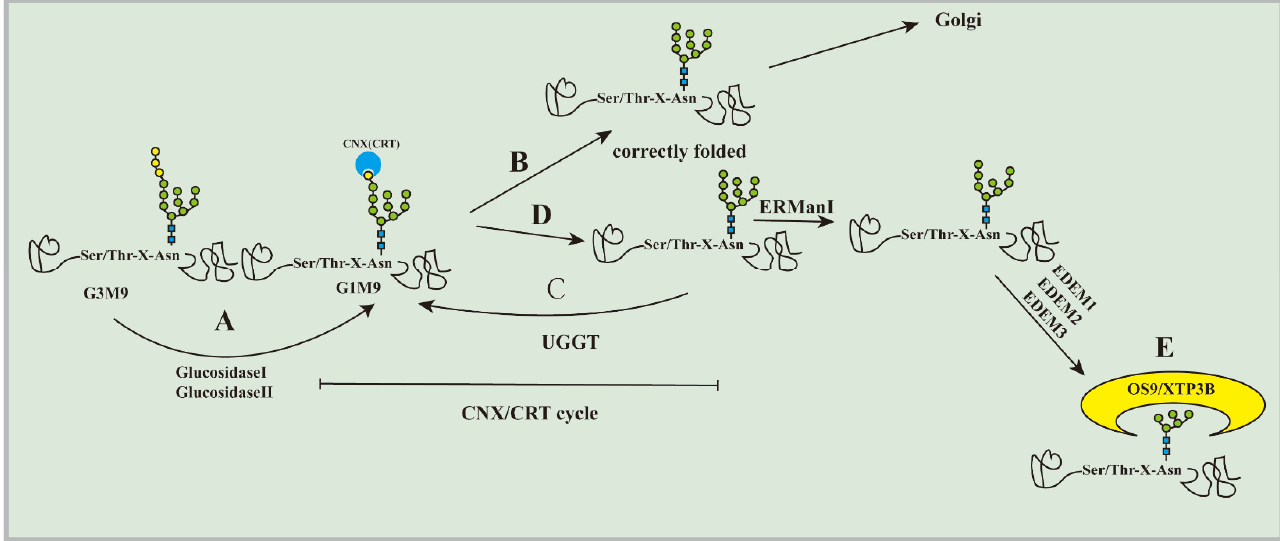
Figure 1. The recognition process of glycoproteins. ( A ) Glycosylation of core glycans under the action of glucosidases leads to the entry of new glycoproteins into the calnexin (CNX)/calreticulin (CRT) cycle. ( B ) The protein folded correctly and exudes to the Golgi. ( C ) Under the act of UGGT, misfolded proteins run back to interact with CNX/CRT for further folding. ( D ) With the act of ERMan\EDEM1\EDEM2\EDEM3, misfolded glycoproteins are separated from CNX/CRT to produce glycan signals for ERAD system identification. ( E ) OS-9/XTP3B recognizes misfolded glycoproteins and submits them to the next step.